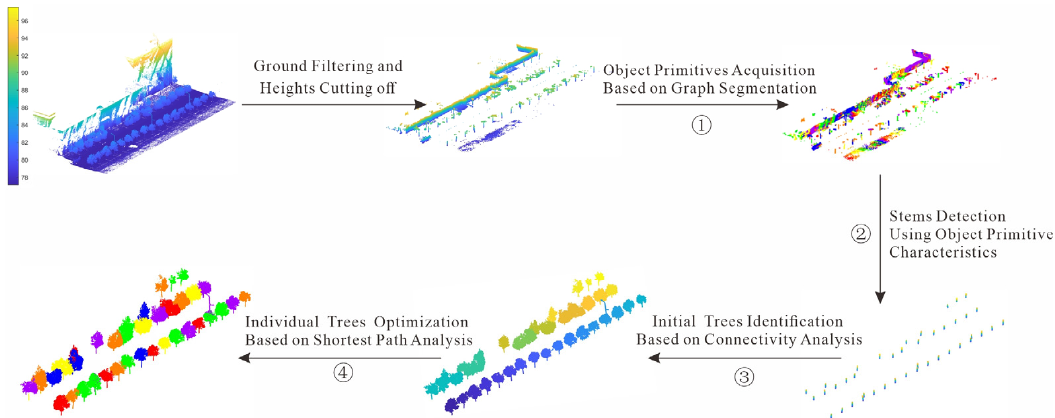
Figure 1. Flowchart of the proposed method.